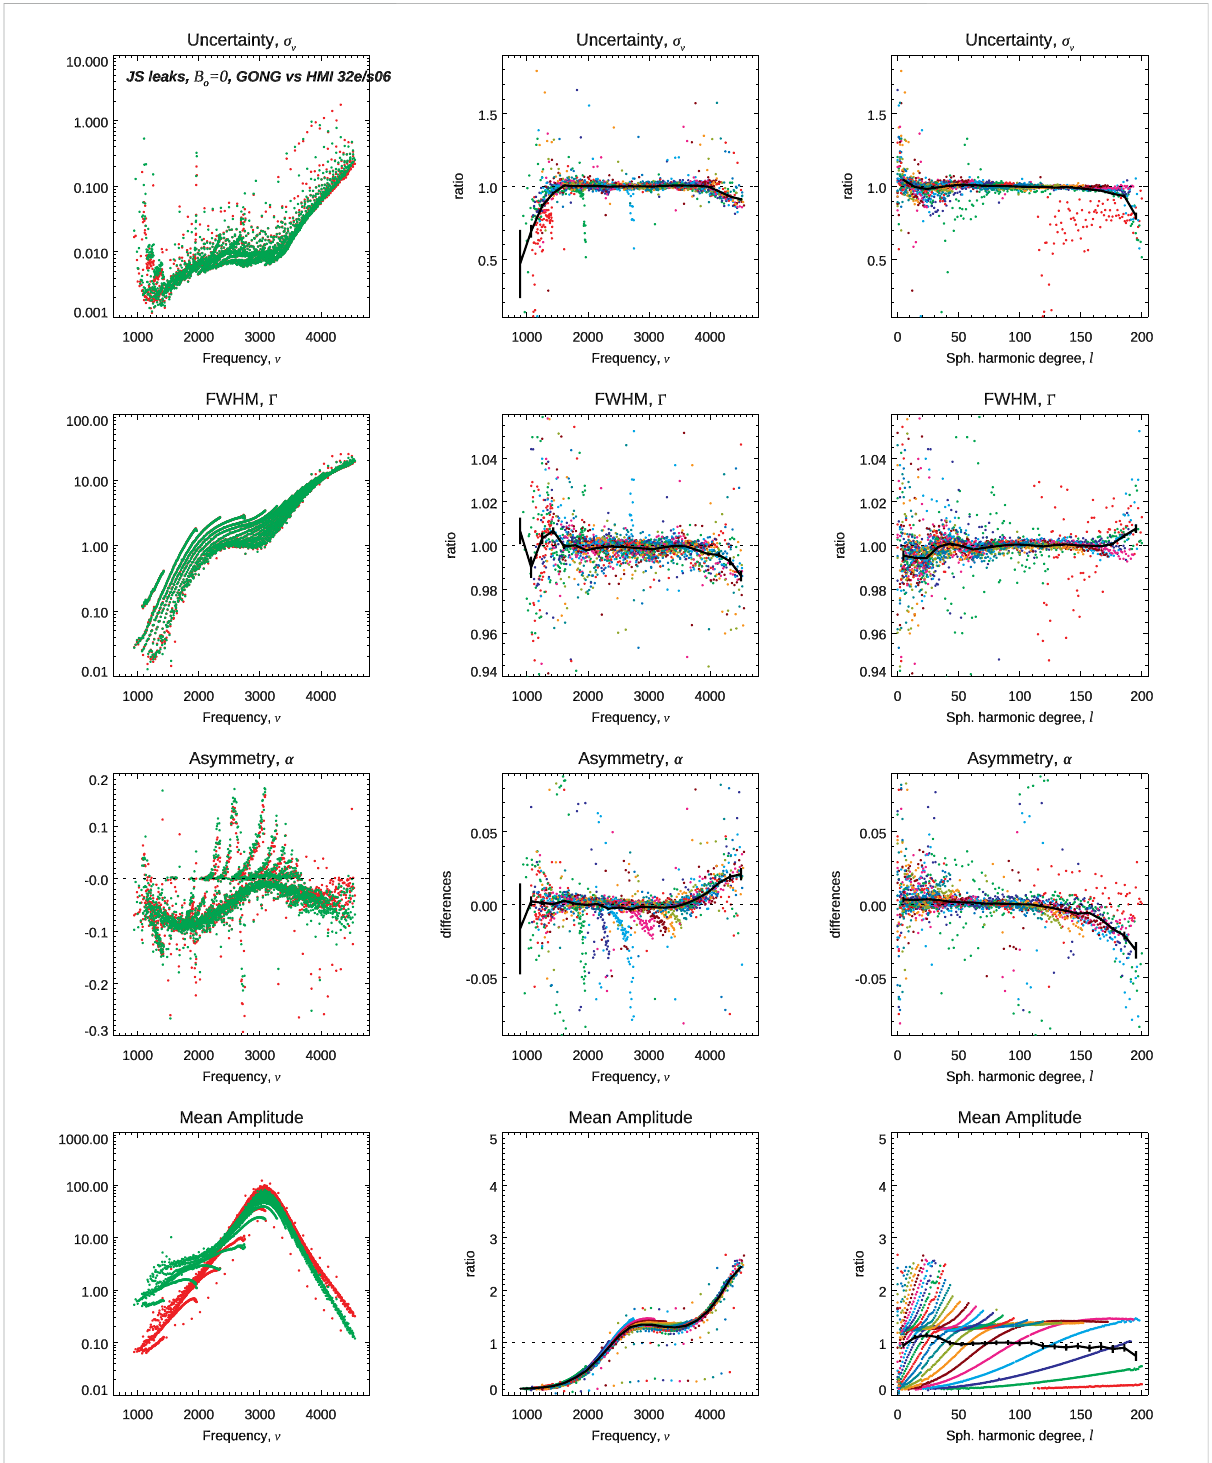
FIGURE 12 Comparison of mode characteristics, σ ] , Γ , α , and (cid:2) A ratios or differences, when fi tting a coeval 2,304-day-long time series of GONG or HMI